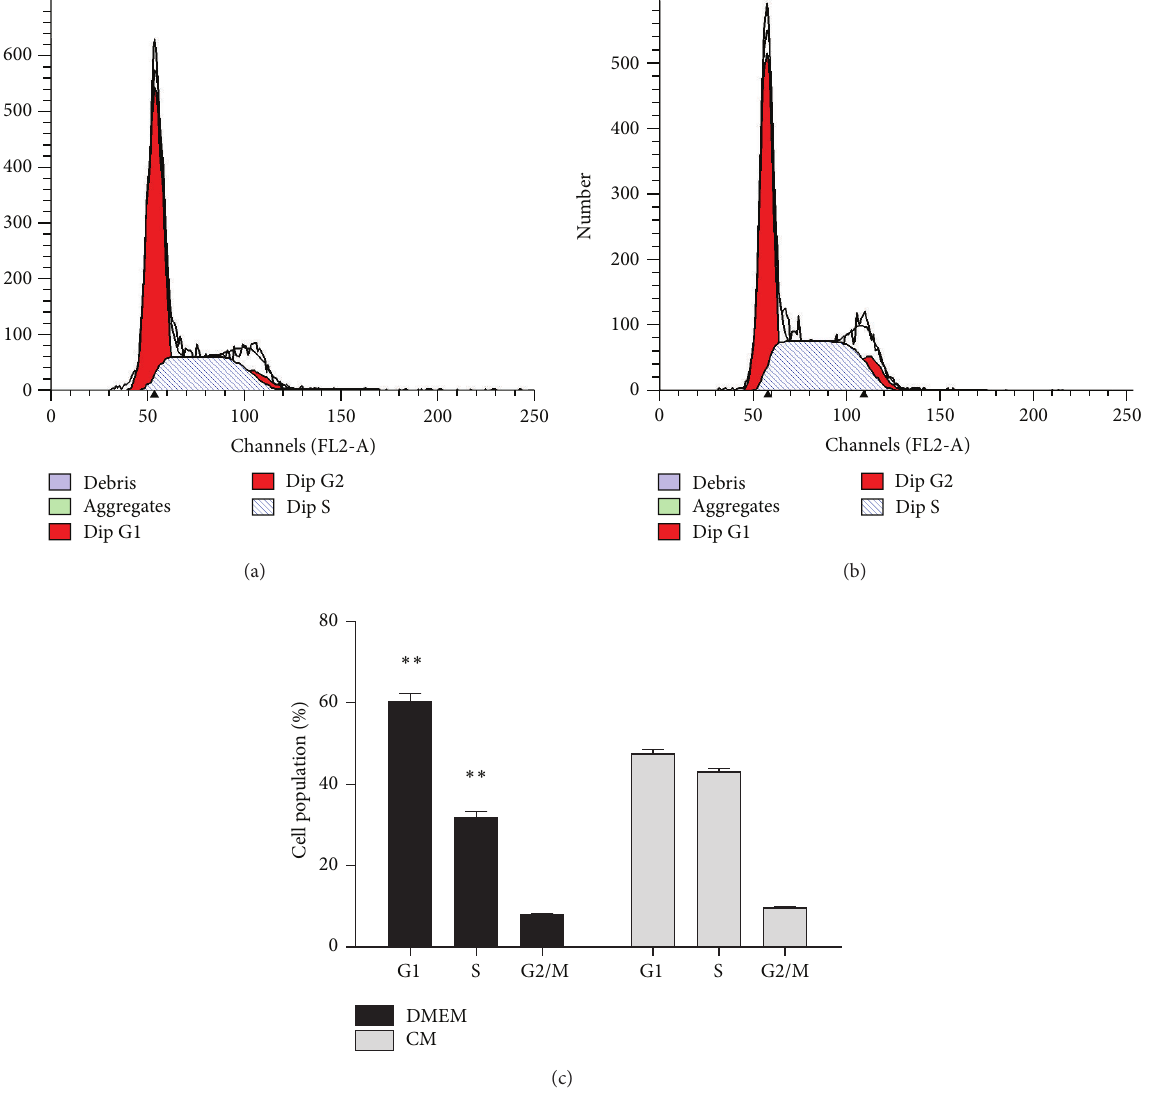
Figure 5: Cell cycle analysis of T24 bladder cancer cells. Cells were treated with DMEM (a) or ADSC-CM (b) for 48 h and then stained with propidium iodide. The DNA content was analyzed by flow cytometry. G1, S, and G2/M indicate cell cycle phase. (c) It shows an obvious S phase arrest with a concomitant decrease of cell number in G1 phase of the cell cycle. The percent of S phase was quantified from three independent experiments ( ∗∗ 𝑃 < 0.01 versus